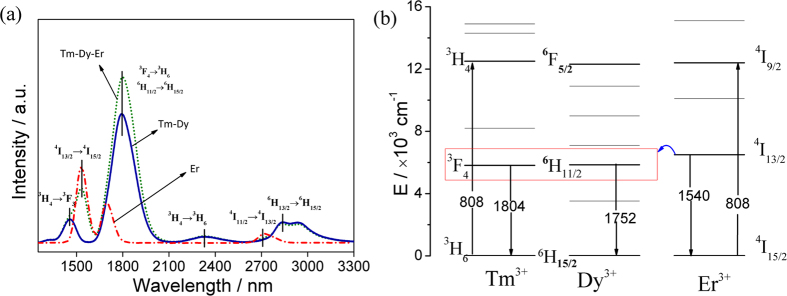
(a) The IR fluorescence spectra and (b) energy transfer scheme of 65GeS2–25In2S3–10CsI glasses with various doping behavior of Er3+, Tm3+-Dy3+, and Tm3+-Dy3+-Er3+.